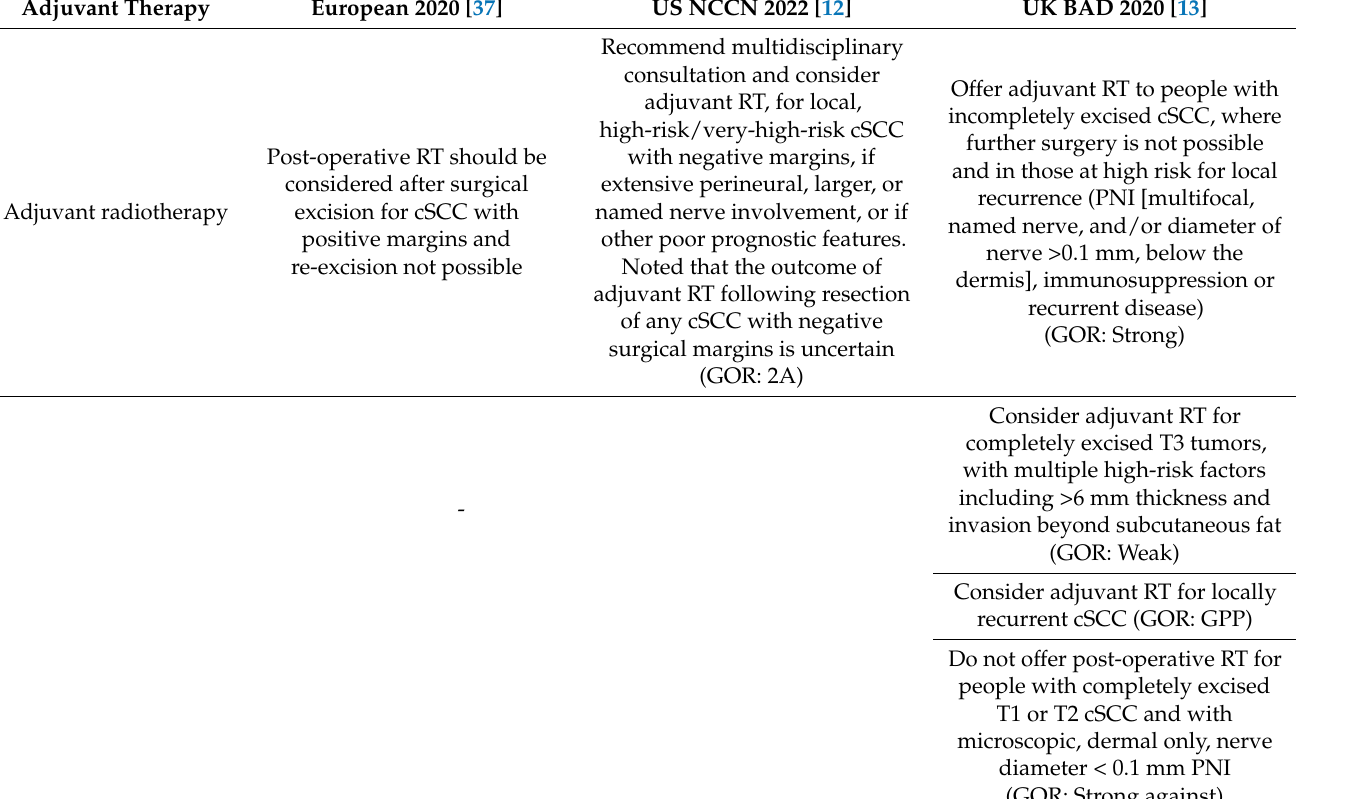
Table 4. Recommendations on adjuvant therapy for high-risk cSCC in current